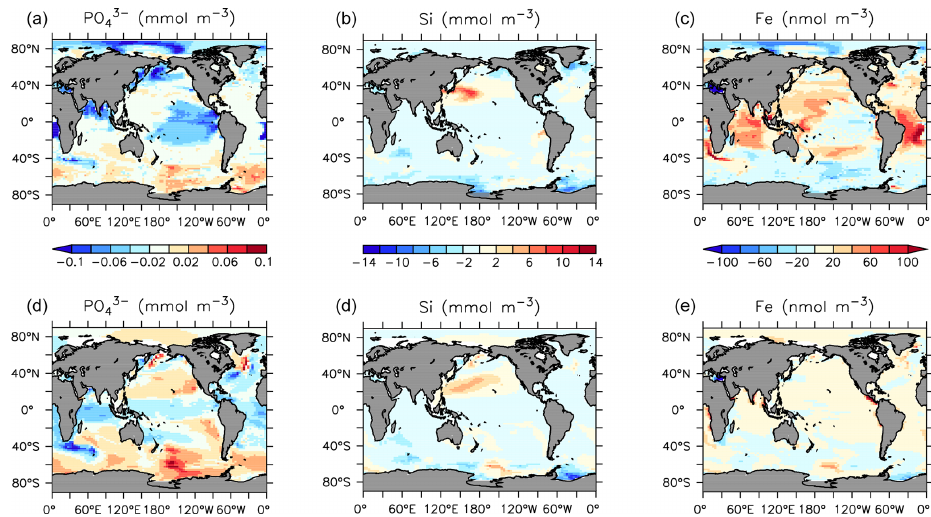
Figure 23. Modelled change in nutrients at the surface (a–c) and 300m depth (d–e) from 1964 to 2014.